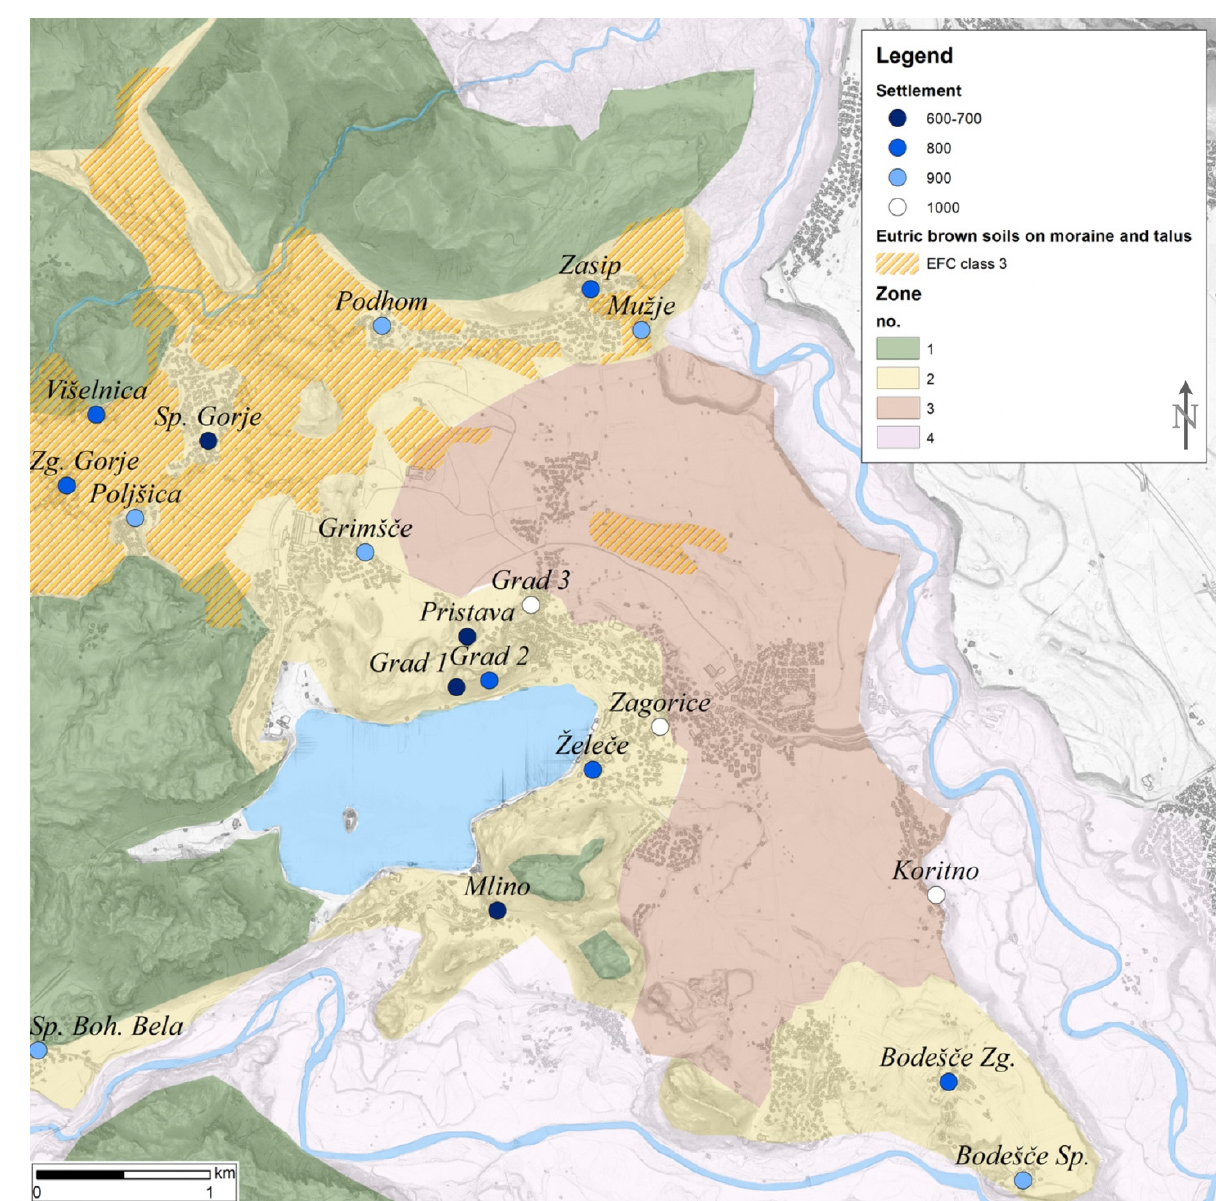
Figure 7. Bled microregion (decimal longitude and latitude coordinates of the map centre: 14.1139; 46.3752), brown soils with high capacity to retain water (marked with dashed lines) and physiographic zones. The areas most suitable for early medieval agriculture are located at the intersection of the dashed lines and yellow Zone 2.